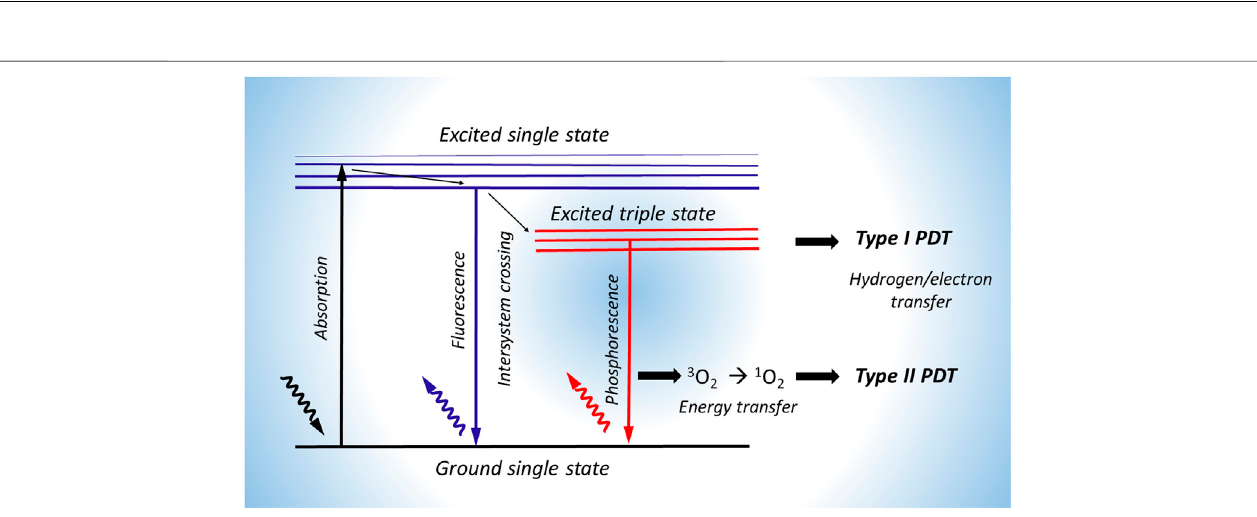
FIGURE 2 | Scheme of the different photosensitization processes after the absorption of a photon by the PS. Two different types of reactions can take place, in Type I process an electron of the PS is transfer by reacting with a nearby substrate forming ROS. The type II reaction involves an energy transferred from the PS triplet state T 1 to the ground state ground-state triplet oxygen ( 3 O 2 ) to generate ( 1 O 2 ).